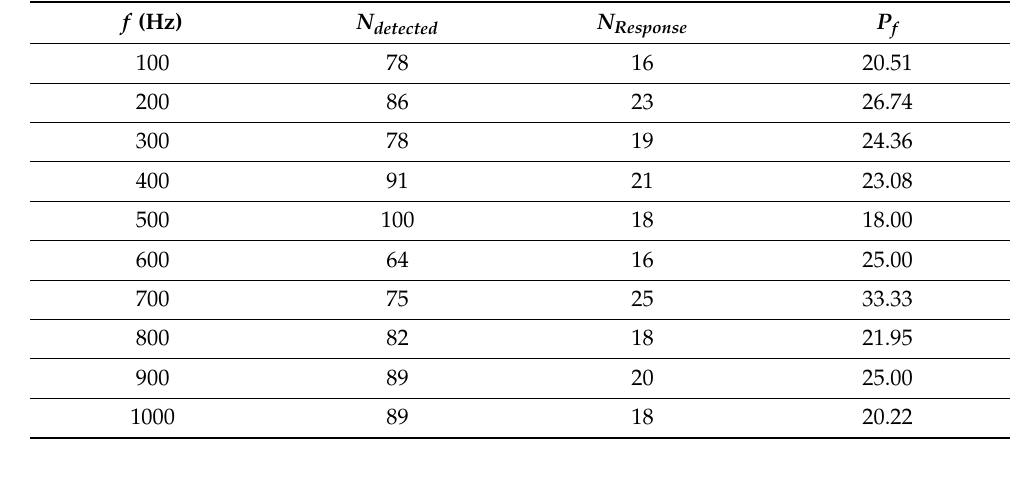
Table 1. Number of larvae that were detected by PTV algorithms and defined as having response to sound stimuli.